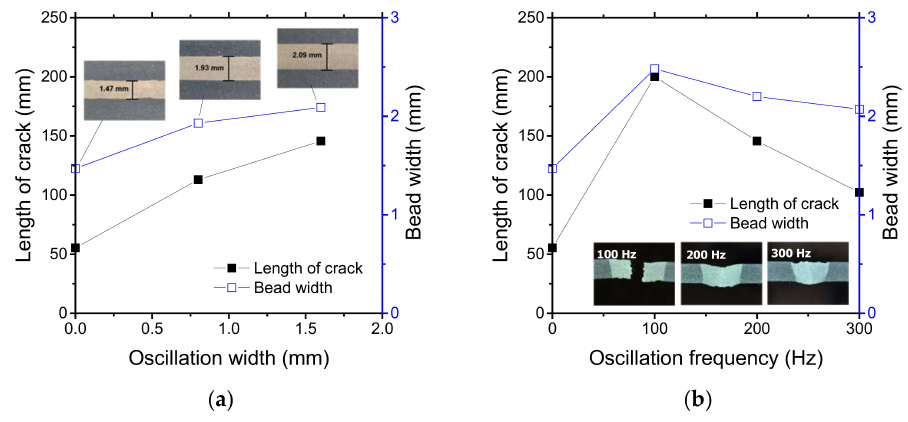
Figure 3. Crack length and bead width measurements at the surface according to ( a ) oscillation width and ( b ) frequency. Specimen was prepared using a circular scanning pattern under a laser power of 900 W and a welding speed of 3